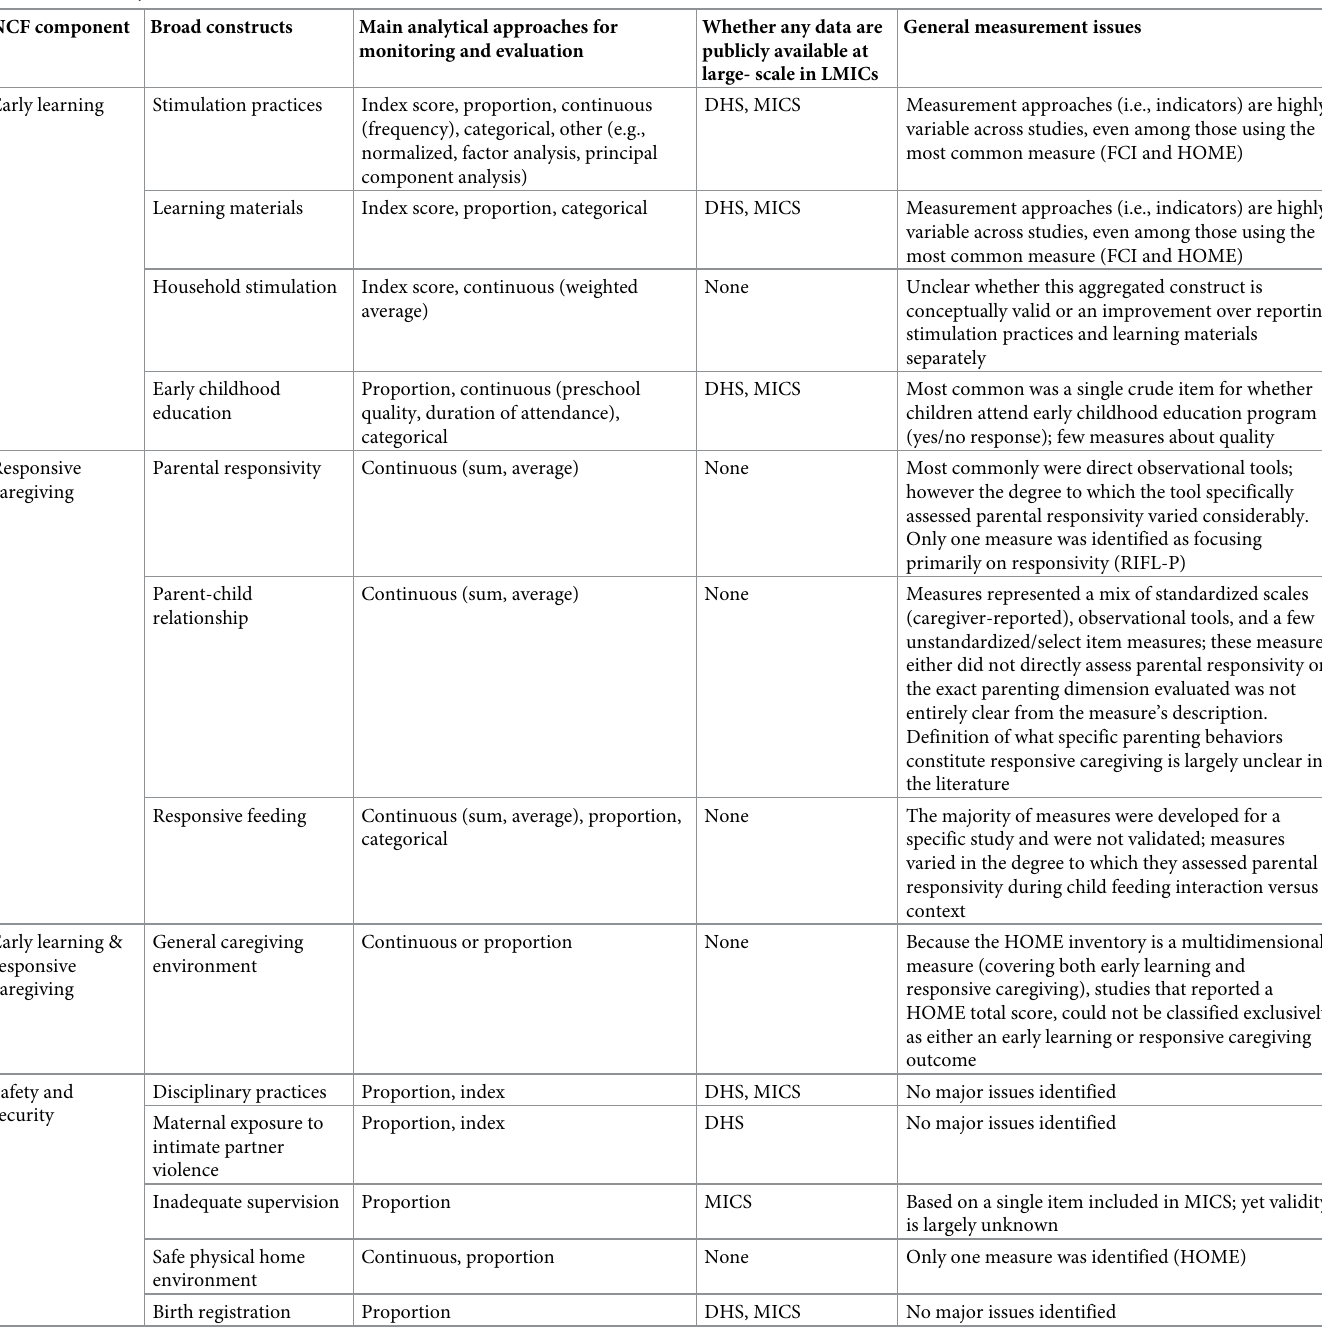
Table 2. Summary table. NCF component Broad